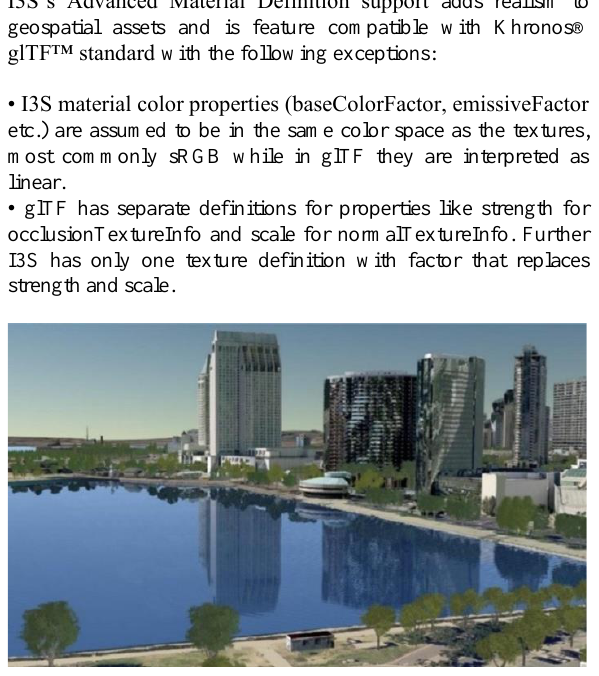
Figure 3 . A snapshot of various I3S layer types showing advanced material support added at OGC Version